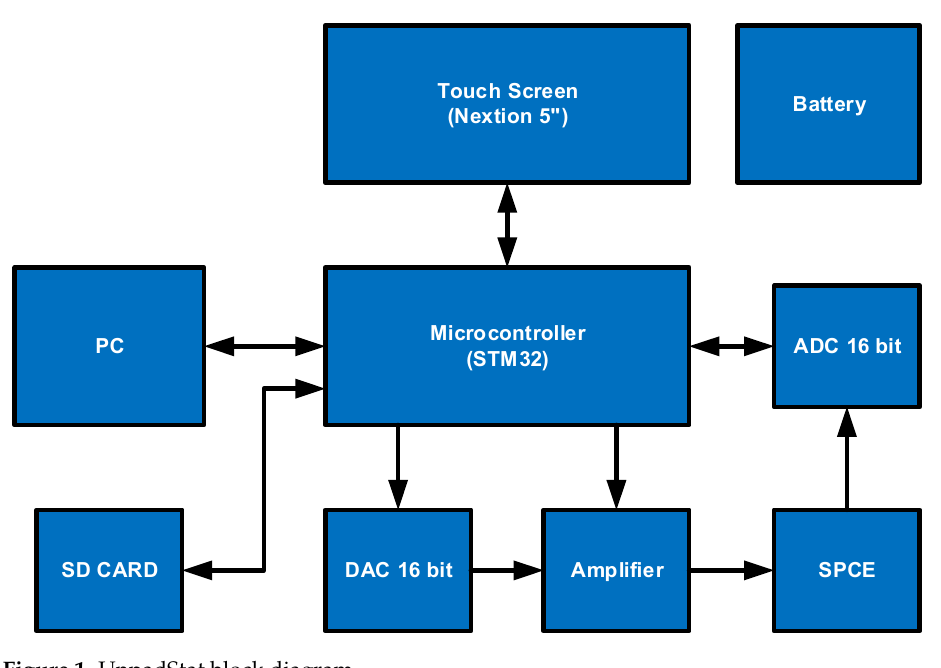
Figure 1. UnpadStat block diagram.